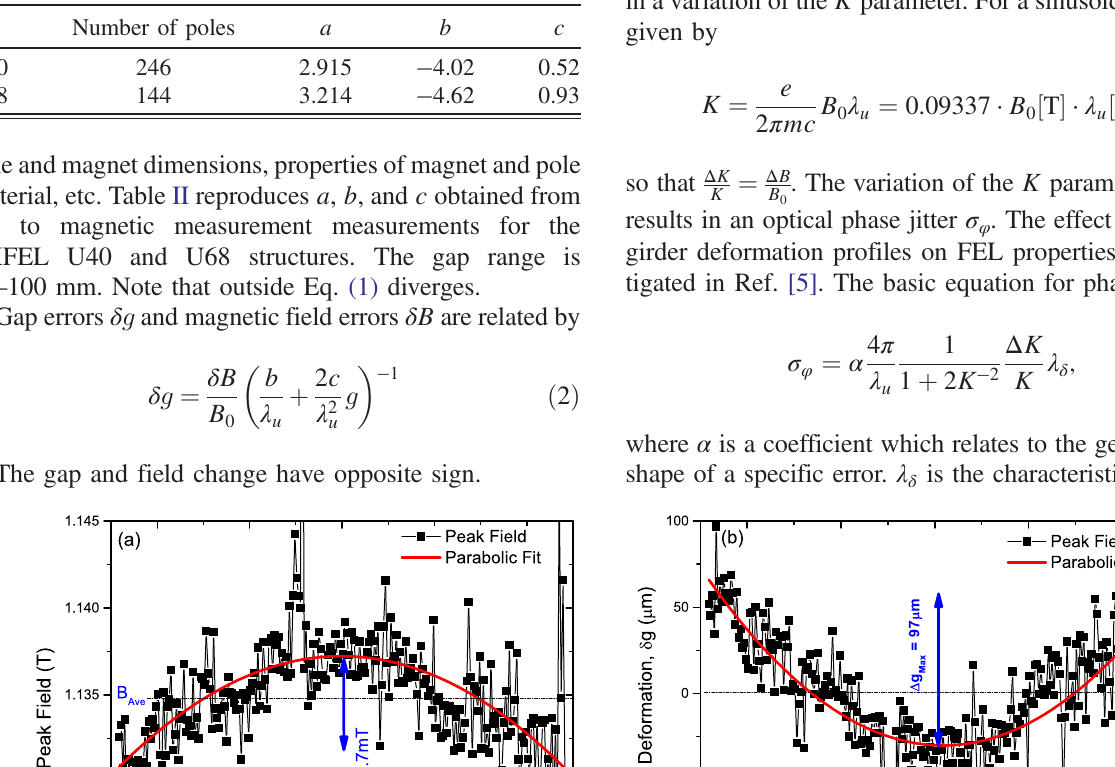
TABLE II. Fitting results for a , b , and c for the U40 and U68 undulators obtained from magnetic measurements in the gap range 10 – 100 mm. They describe the field with a typical rms residual error of ≤ 5 × 10 − 4 T.